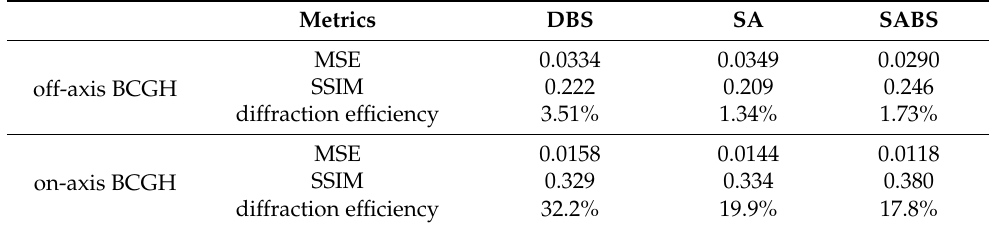
Figure 6. On-axis BCGHs and the reconstructed images. The BCGHs are produced by DBS ( a ), SA ( b ), and SABS ( c ), respectively. Their reconstructed images are in ( d ), ( e ), and ( f ), respectively. Table 1. Performances of different BCGH